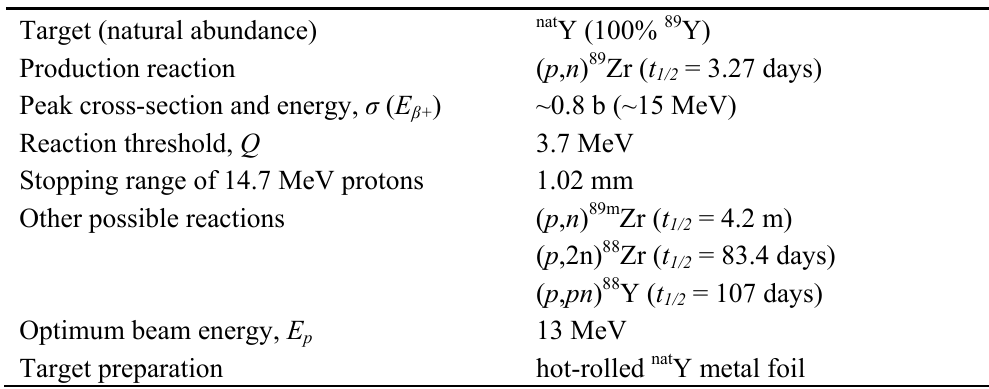
Table 2. Summary of characteristics for production of 89 Zr using a low-energy, biomedical